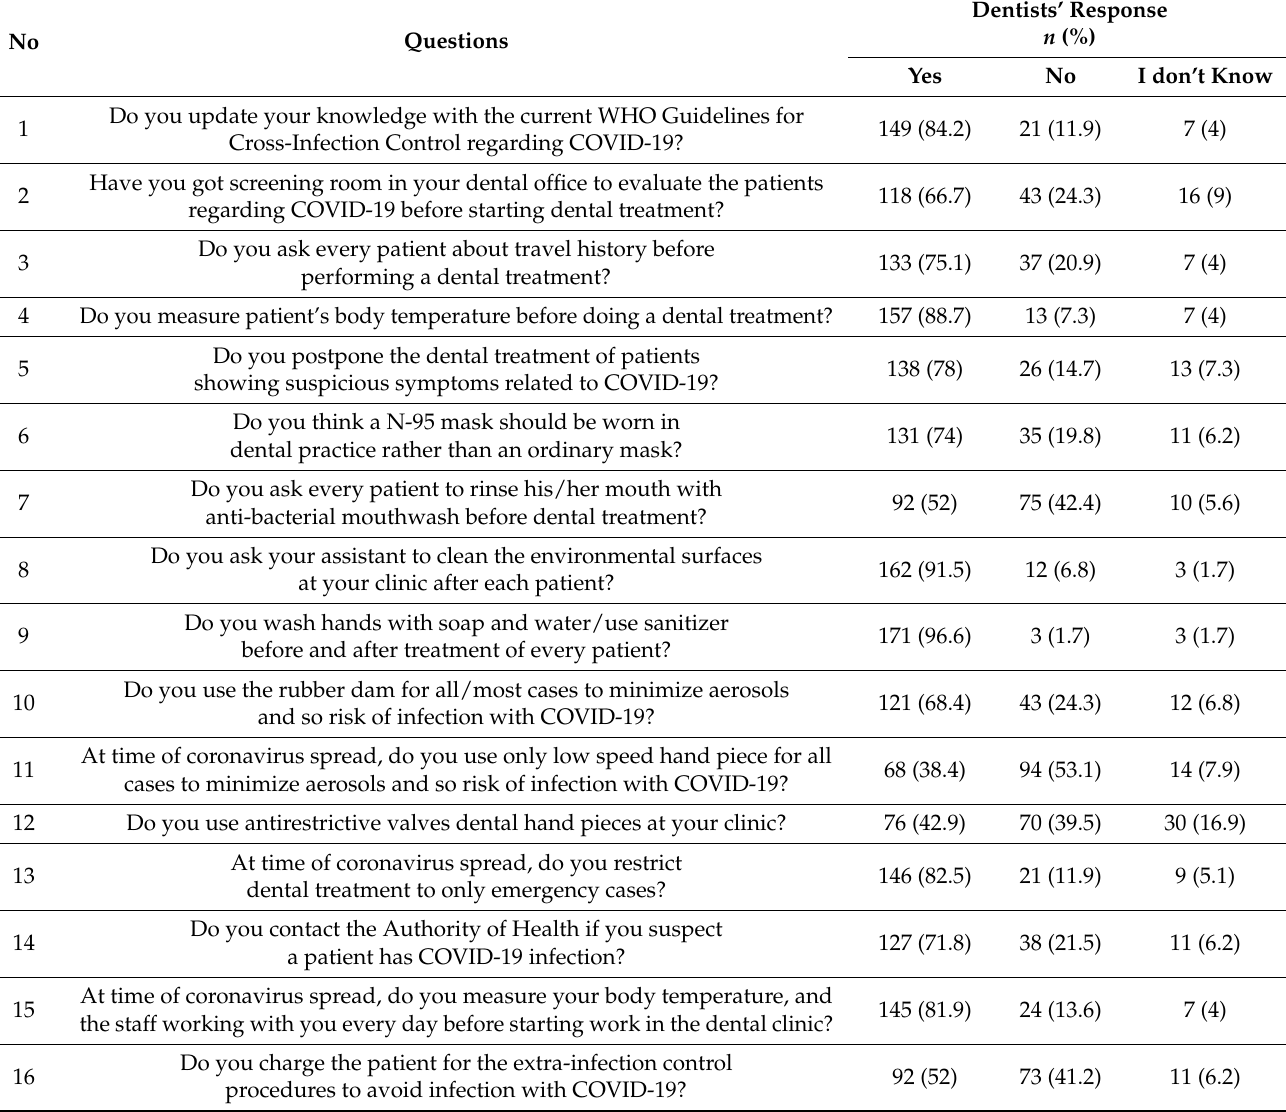
Table 3. Response of participating dentists to practice related questions about COVID-19 (No =